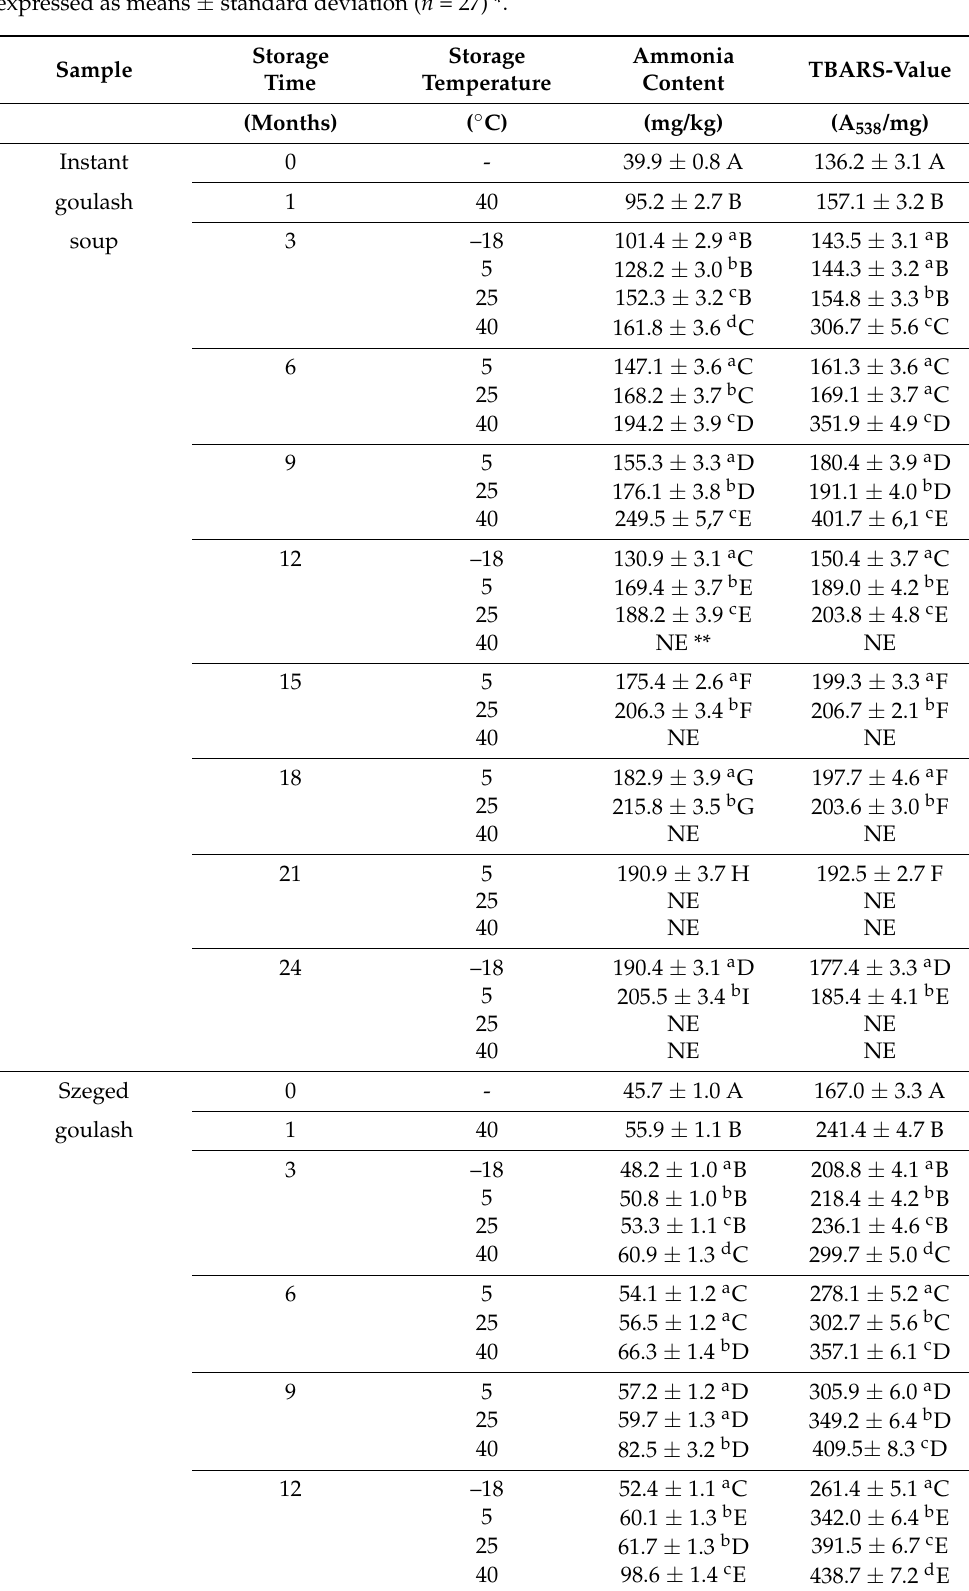
Table 3. Result of the ammonia content (mg · kg − 1 ) (% w / w ) and TBARS-value (A 538 · mg − 1 ) during 24-month period at four different temperatures ( − 18 ◦ C, 5 ◦ C, 25 ◦ C and 40 ◦ C). Instant goulash soup, Szeged goulash, canned chicken meat, pork p â t é and canned tuna fish were tested. The results are expressed as means ± standard deviation ( n = 27)